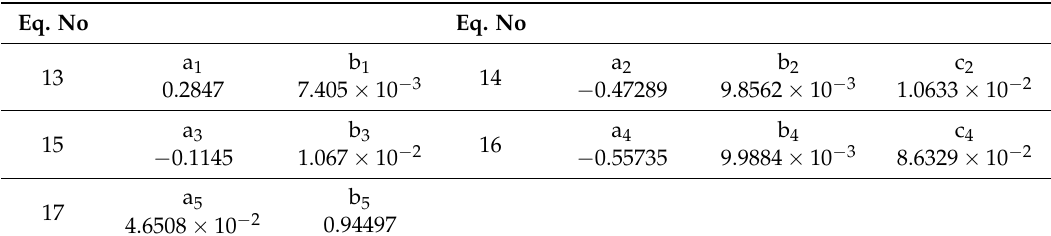
Figure 2. Relationship between HHV with ( a ) C content and ( b ) H content of torrefied wood. For prediction of the HHV r , an R 2 value of 92.80% with an RMSE of 0.023 is obtained by taking C r as the only independent variable. H r is not included as an additional variable because it does not have significance impact on HHV, which is also evident in Figure 2b. The values of the coefficients of Equations (13)–(17) in Table 3 are given in Table 4. Table 4. The coefficients of Equations (13)–(17).